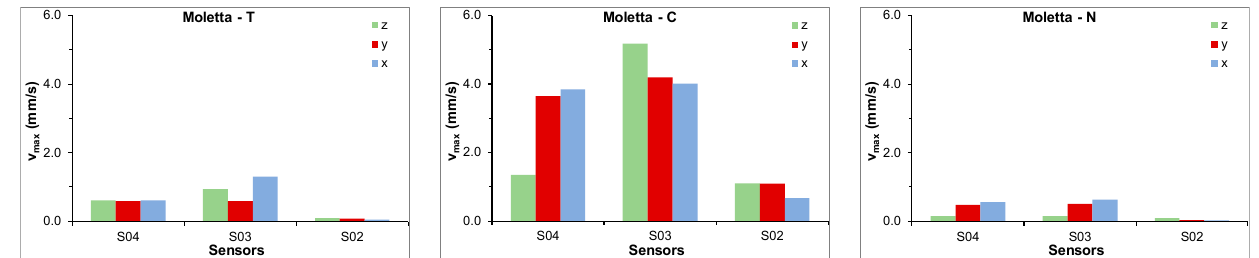
Figure 18. Torre della Moletta: the maximum velocity in the three time intervals.